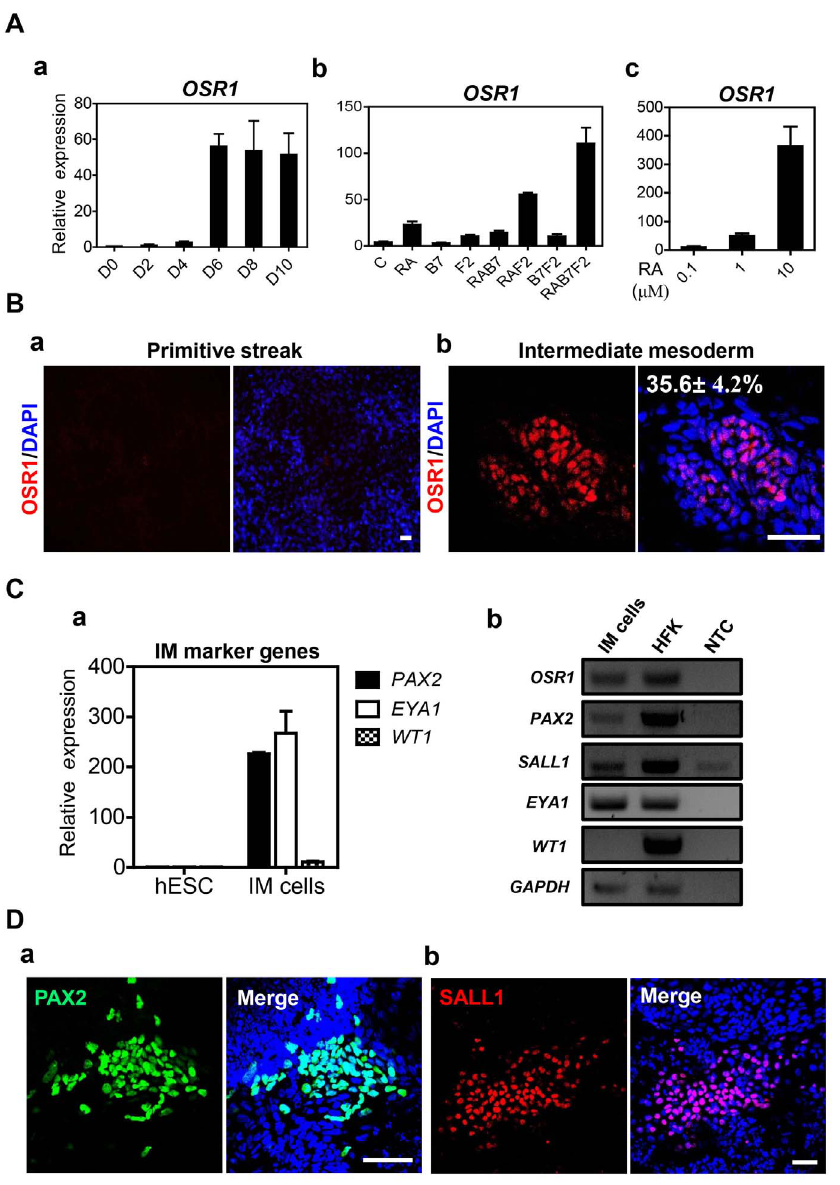
Figure 3. Specification of intermediate mesoderm (IM) from the hESC-derived PS cells. A. (a) Optimal timing for IM induction was determined by transcriptional expression level of OSR1 , comparing with expression values of undifferentiated hESCs, in hESC-derived cells. Relative gene expression was normalized to GAPDH, and the values of fold-changes are represented by mean 6 S.E.M (n=3). (b) Comparison of OSR1 transcripts by combinatorial treatments with exogenous growth factors of retinoic acid (RA), BMP7 (B7) and FGF2 (F2). Untreated samples were designated as (C). Transcriptional expression levels were normalized to GAPDH, and results of fold-change are indicated as mean 6 S.E.M (n=3). (c) Comparison of OSR1 transcription levels by the concentration of RA treatment, including 0.1, 1 and 10 m M. Relative gene expression was normalized to GAPDH. The values of fold-changes are represented by mean 6 S.E.M (n=3). B. Immunocytochemistry for representative expression of OSR1 (red) in (a) hESC-derived PS and (b) IM cells. Quantification of the number of cells expressing the key markers of specific differentiation stage was performed by manual counting in three randomly chosen fields. Scale bars=50 m m. C. Transcriptional expression of various IM marker genes were evaluated by (a) real time RT-PCR and (b) RT-PCR in hESC-derived IM cells. Human fetal kidney (HFK) cDNA was used as positive control. Relative transcriptional levels were normalized to GAPDH, and the bars show mean 6 S.E.M (n=3). D. Immunostaining of PAX2 (green) and SALL1 (red) at the end of IM induction in hESC-derivatives. Scale bars=100 m